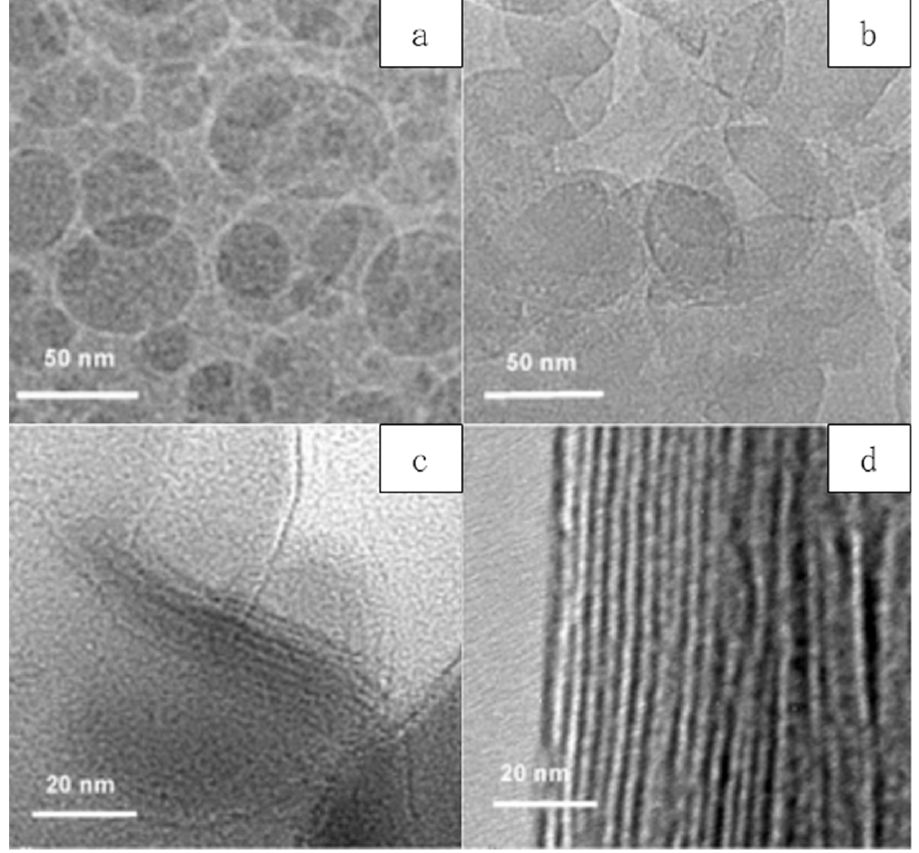
Figure 10. TEM images of LDHs synthesized in reverse micelles with the water / surfactant fraction of 12 ( a ), 24 ( b ), 36 ( c ), and 48 ( d ). Reproduced with permission from reference [115].